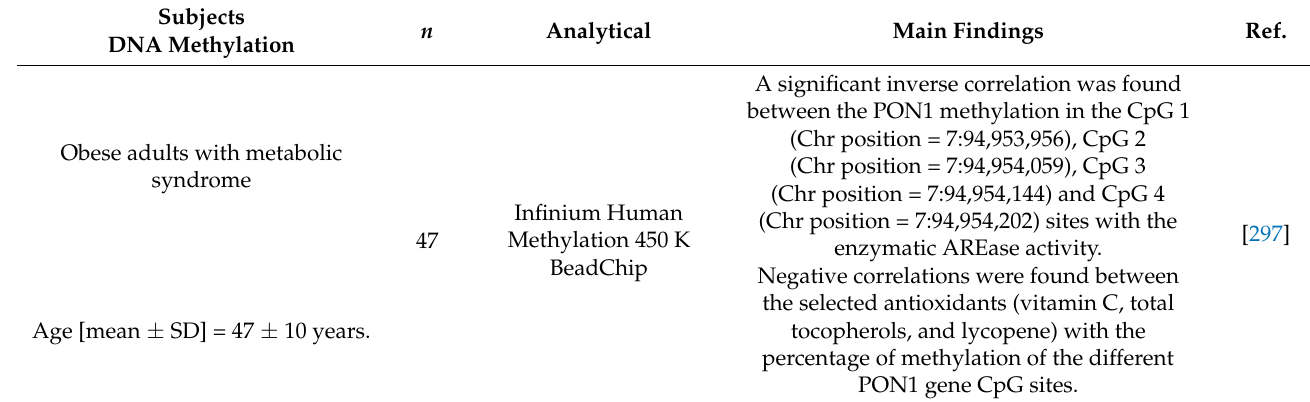
Table 2. Epigenetic regulation and PON1